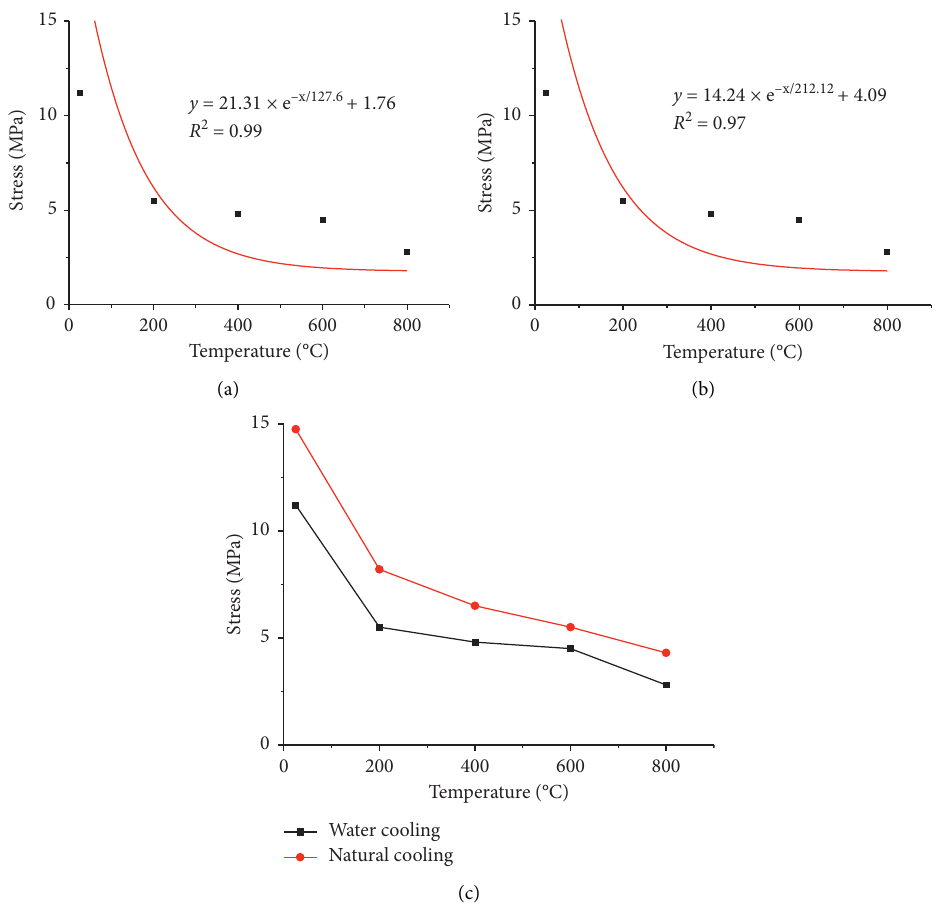
Figure 11: Relationship between tensile strength and temperature (natural cooling and water cooling). (a) Natural cooling; (b) water cooling; (c) effect of cooling mode on tensile strength of